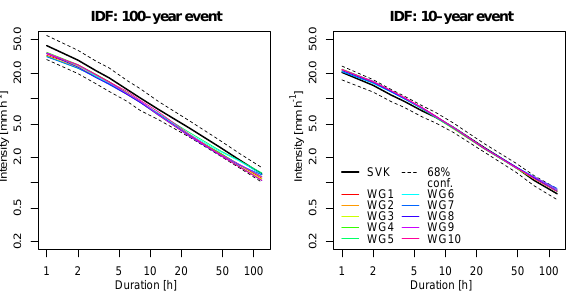
Figure 7. Mean intensity–duration–frequency curves for 100- and 10-year return periods calculated from the SVK data set and for all 10 WG realizations; 68% confidence interval for the SVK data set.